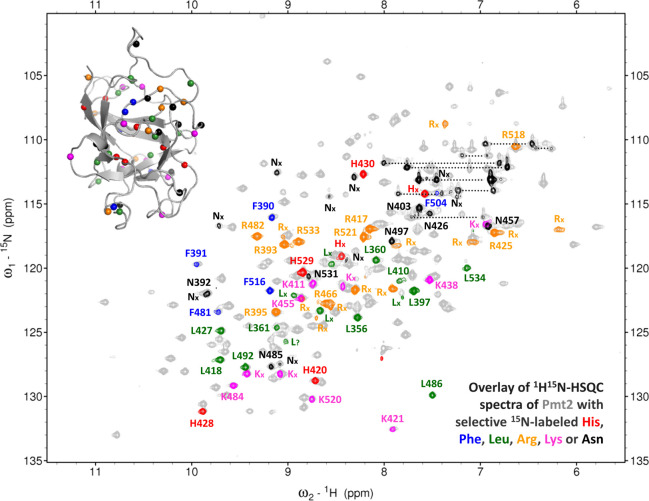
Selective 15N-labeling of amino acids in Pmt2-MIR.Overlay of the 1H15N-HSQC spectra of uniform 15N-labeled Pmt2-MIR domain (gray) with the ones in which selective amino acid are labeled (His in red, Phe in blue, Leu in green, Arg in orange, Lys in magenta and Asn in black). The backbone amide assignment is indicated (those which are ambiguous are marked with an x). The labeled amino acid positions are indicated (same color coding) in the inserted X-ray crystal structure of the MIR domain. The spectra of these selective labeled samples assist the NMR assignment and confirm the type of amino acid.